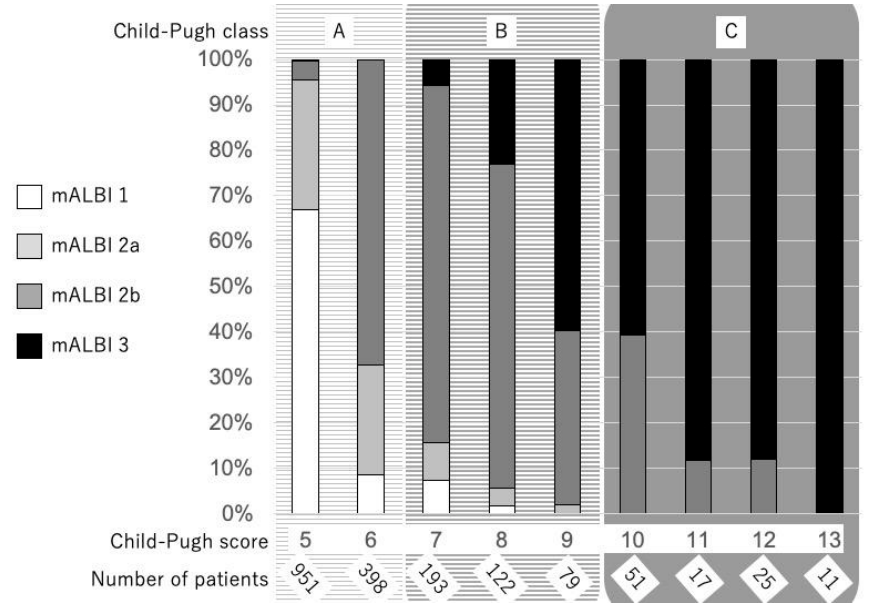
Figure 1. Distribution of mALBI grades with the Child–Pugh score in 1850 HCC patients treated at Ehime Prefectural Central Hospital from 2000 to 2019. Ehime Prefectural Central Hospital from 2000 to